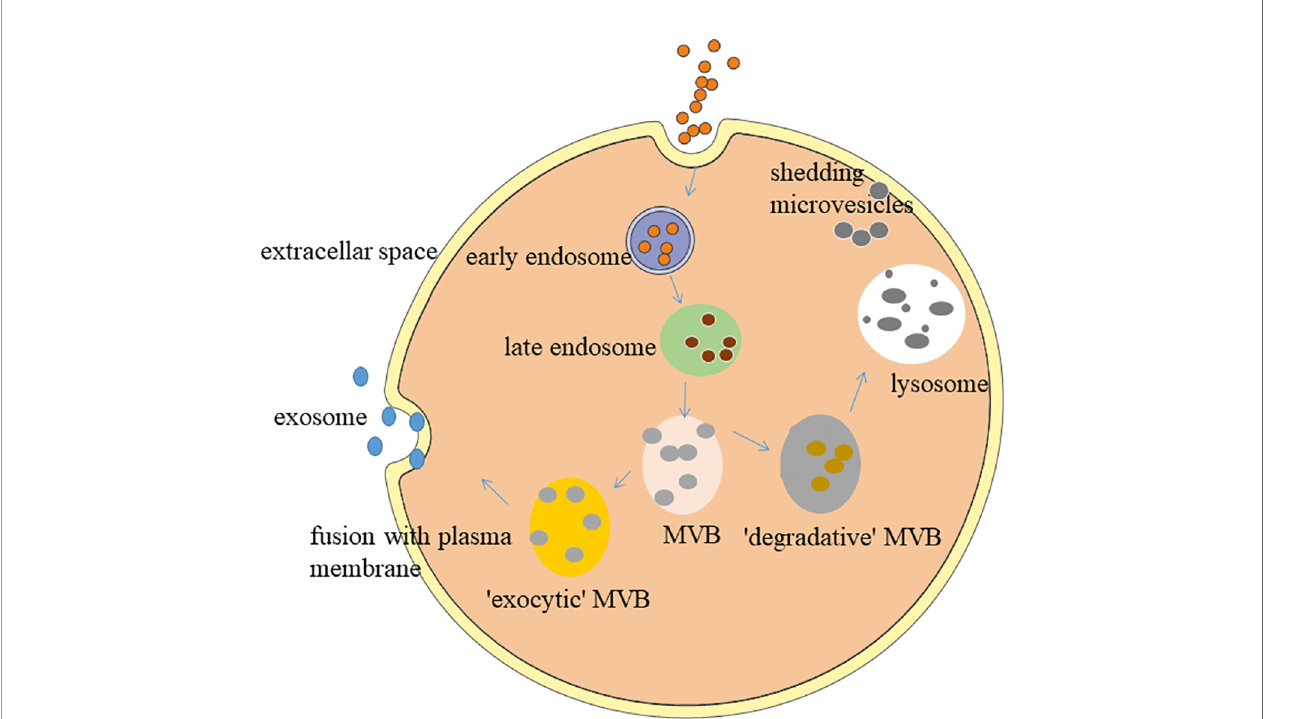
FIGURE 1 | Biogenesis of small extracellular vesicles. The formation of sEVs originates from a series of regulation processes of “ endocytosis-fusion-ef fl ux ” ; that is, early endosomes formed after the plasma membrane of the cell is recessed. The envelope of early endosomes keeps invading and selectively accepts biologically active components, such as proteins, nucleic acids, and lipids in the cells, and eventually forms late endosomes. Late endosomes produce multiple intraluminal vesicles in the form of internal budding, which selectively receive cytosolic proteins, nucleic acids, or lipids to form multivesicular bodies (MVB). MVB are divided into exocytic-MVB and degradative-MVB. Exocytic-MVB release the vesicles in the MVB to the outside of the cell in the form of exocytosis through the plasma membrane fusion mediated by Rab27, and the released membranous vesicles are the sEVs. Degradative-MVB are degraded by fusion with lysosomes (50,